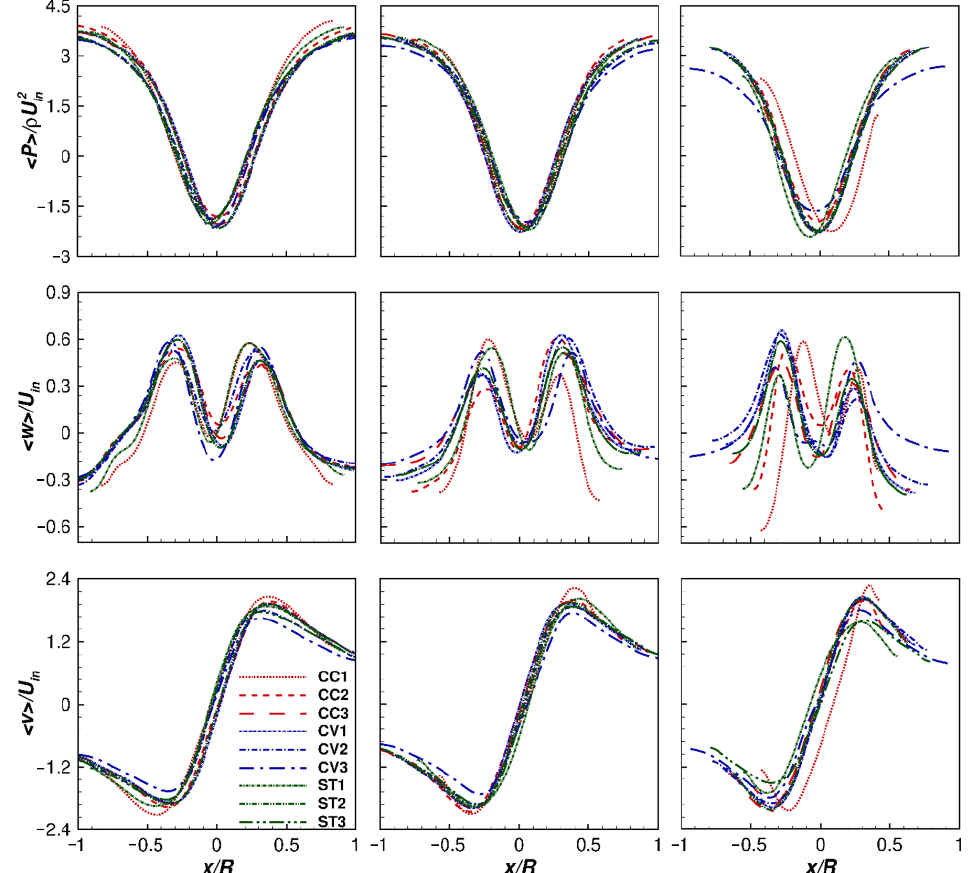
Figure 6. From left to right: the radial profiles at z/D = 1.0, 2.0, and 3.0 of mean static pressure, mean axial velocity and mean tangential velocity (top to bottom), respectively, in different cyclone mod- els.